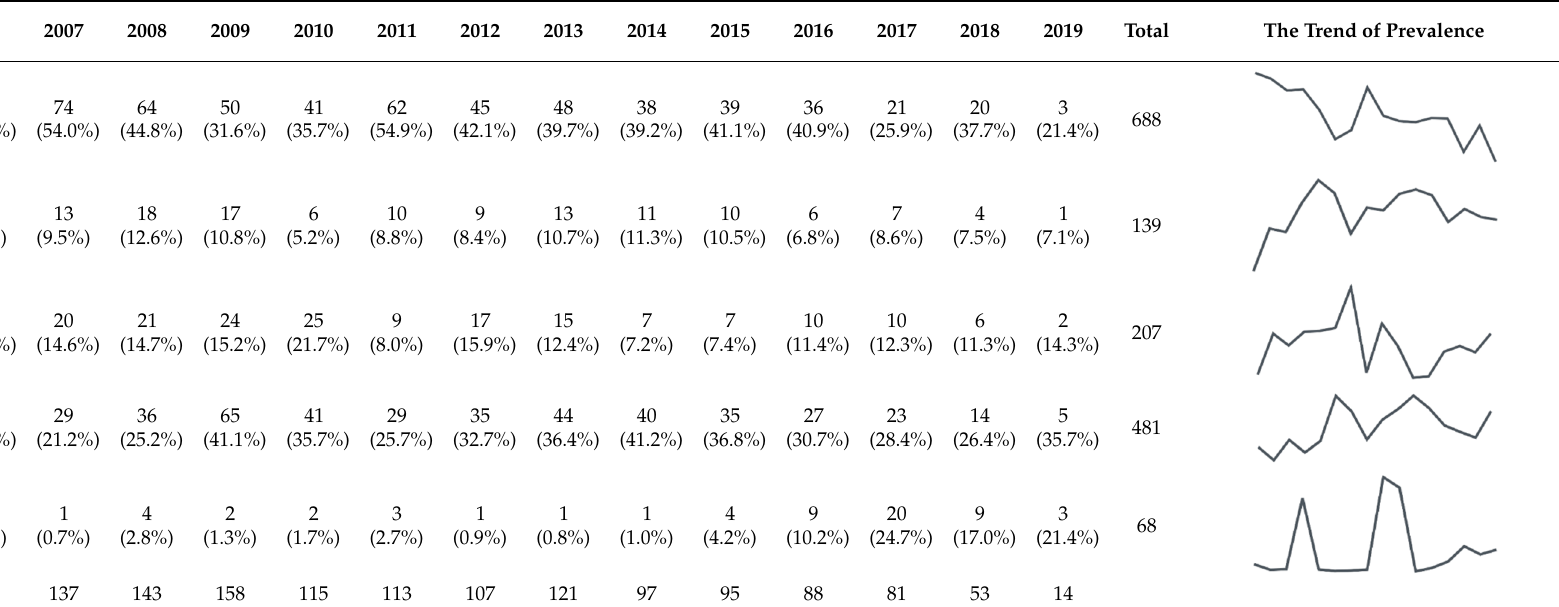
The prevalences of serogroup B, serogroup D and serogroup E showed significant differences between years ( p = 0.000, p = 0.001 and p = 0.000 respectively). By post hoc comparison, the prevalence of serogroup B demonstrated a decreasing trend ( p = 0.000) while those of se. Table 2. Association between antimicrobial non-susceptibility to different serogroups of NTS. Serogroup B Serogroup C1 Serogroup C2 Serogroup D Serogroup